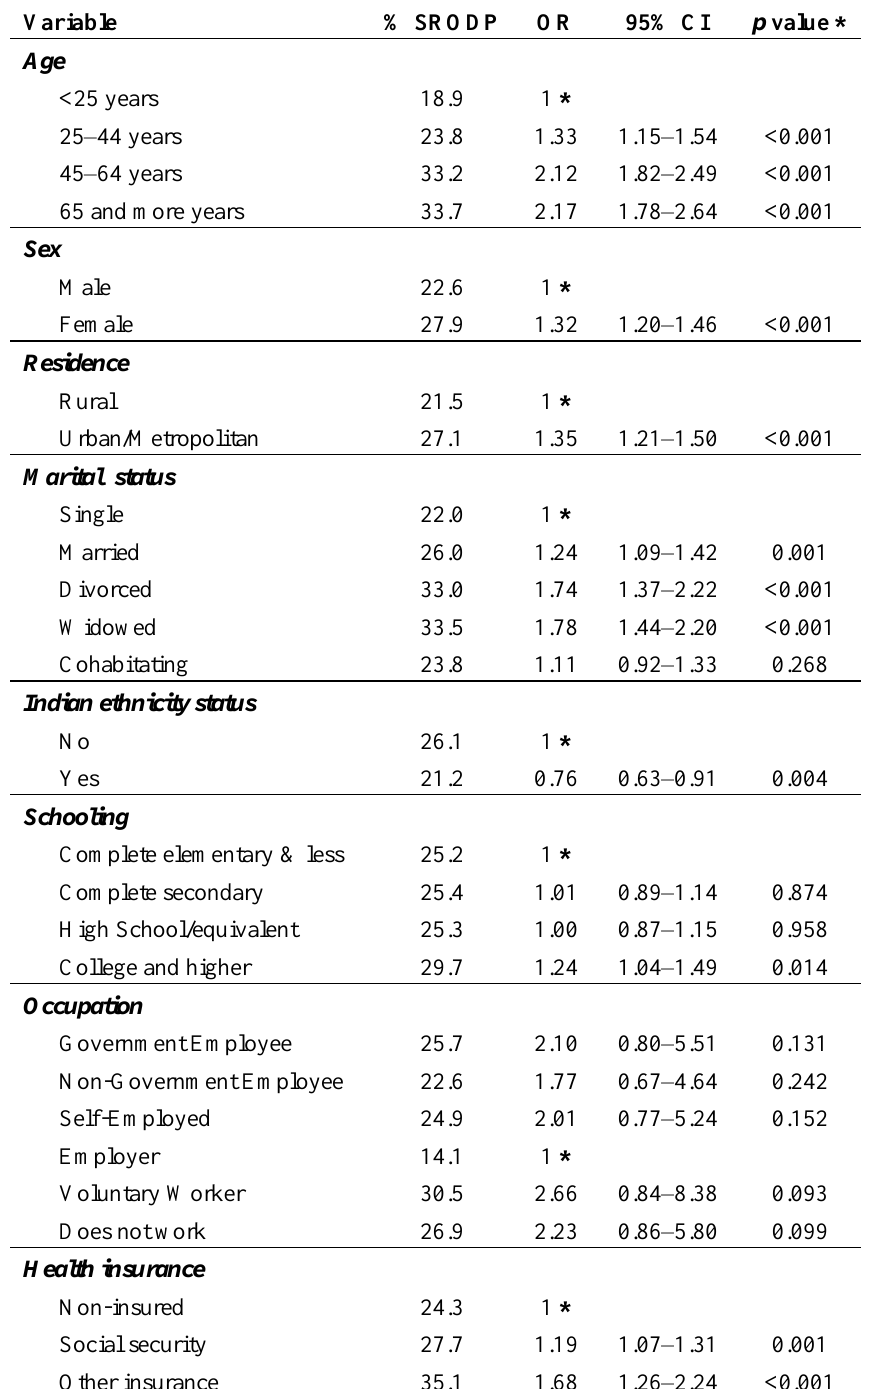
Table 2. Bivariate analyses of the prevalence of self-report of oral and dental problems and independent variables (National Performance Evaluation Survey